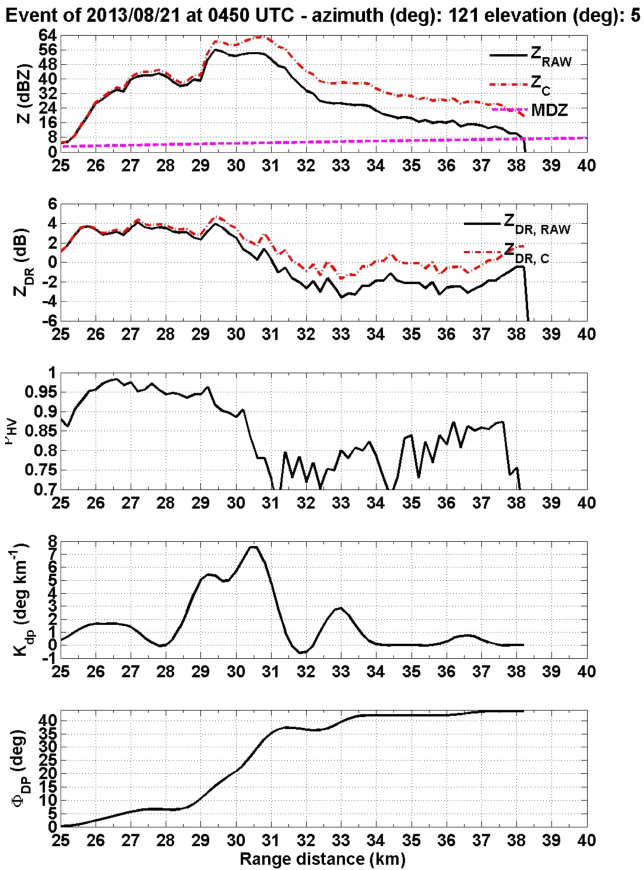
Figure 13. Range plots of the polarimetric radar parameters Z H , Z DR , ρ HV , K DP and (cid:56) DP taken at 121 ◦ of azimuth and 5 ◦ of antenna elevation on 21 August 2013 at 04:50UTC. The two upper panels also show the attenuation-corrected reflectivity and differential reflectivity. The minimum detectable Z H (MDZ) is also plotted on the upper